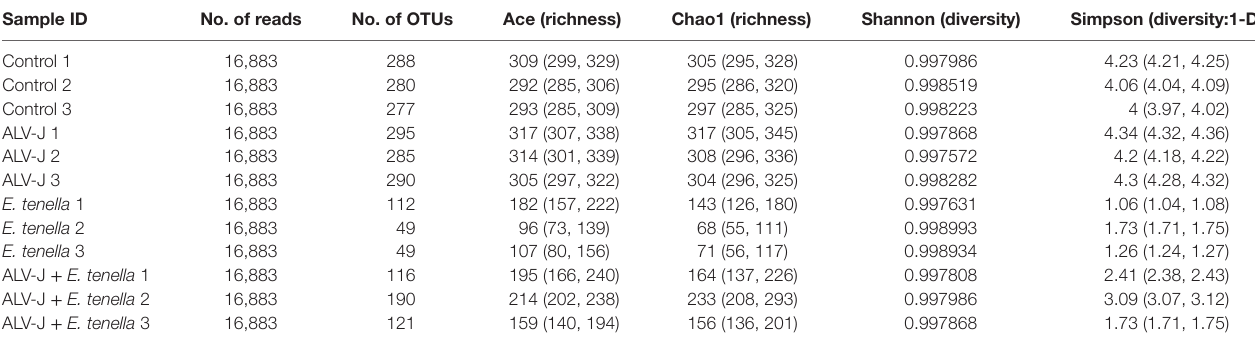
TaBle 1 | Number of OTUs per groups and estimators of sequence diversity and richness. sample iD